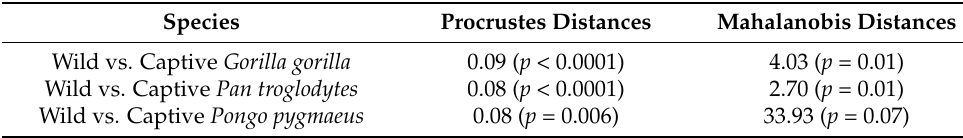
Table 2. Procrustes and Mahalanobis distances between wild and captive